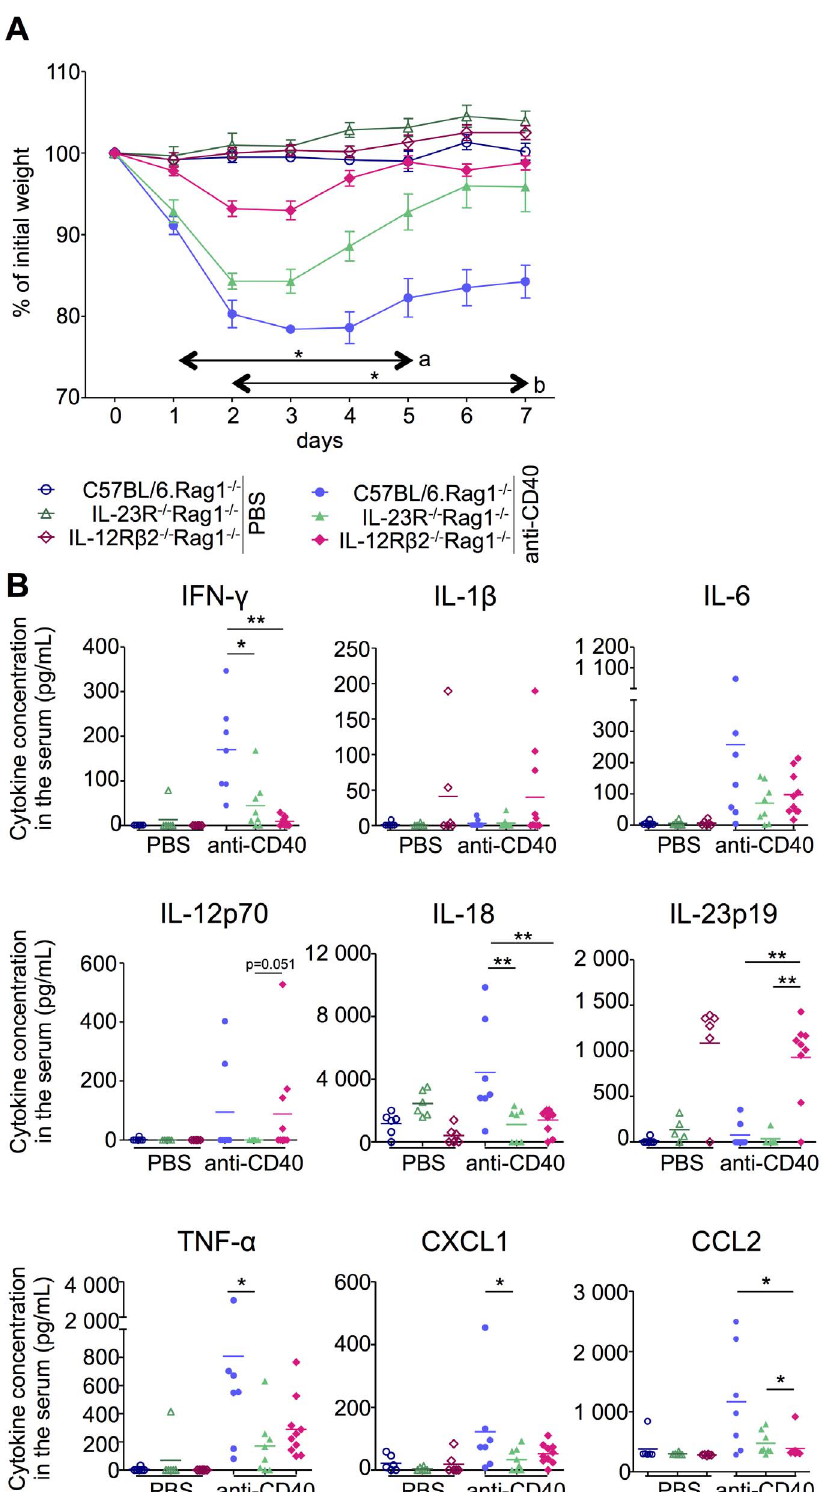
Figure 6. IL-12R b 2 + and IL-23R + innate immune cells both contribute to the systemic inflammatory response. C57BL/6.Rag1 2 / 2 , IL- 23R 2 / 2 .Rag1 2 / 2 , and IL-12R b 2 2 / 2 .Rag1 2 / 2 mice were injected with anti-CD40 antibody or PBS (6 to 11 mice per group). (A) Mouse weight relative to the initial weight is shown. a, b p , 0.05. (B) Day 7 serum concentrations of IFN- c , IL-1 b , IL-6, IL-12p70, IL-18, IL-23p19, TNF- a , CCL-2 and CXCL1 were quantified. Each symbol represents data for one mouse. * p , 0.05, ** p , 0.01.